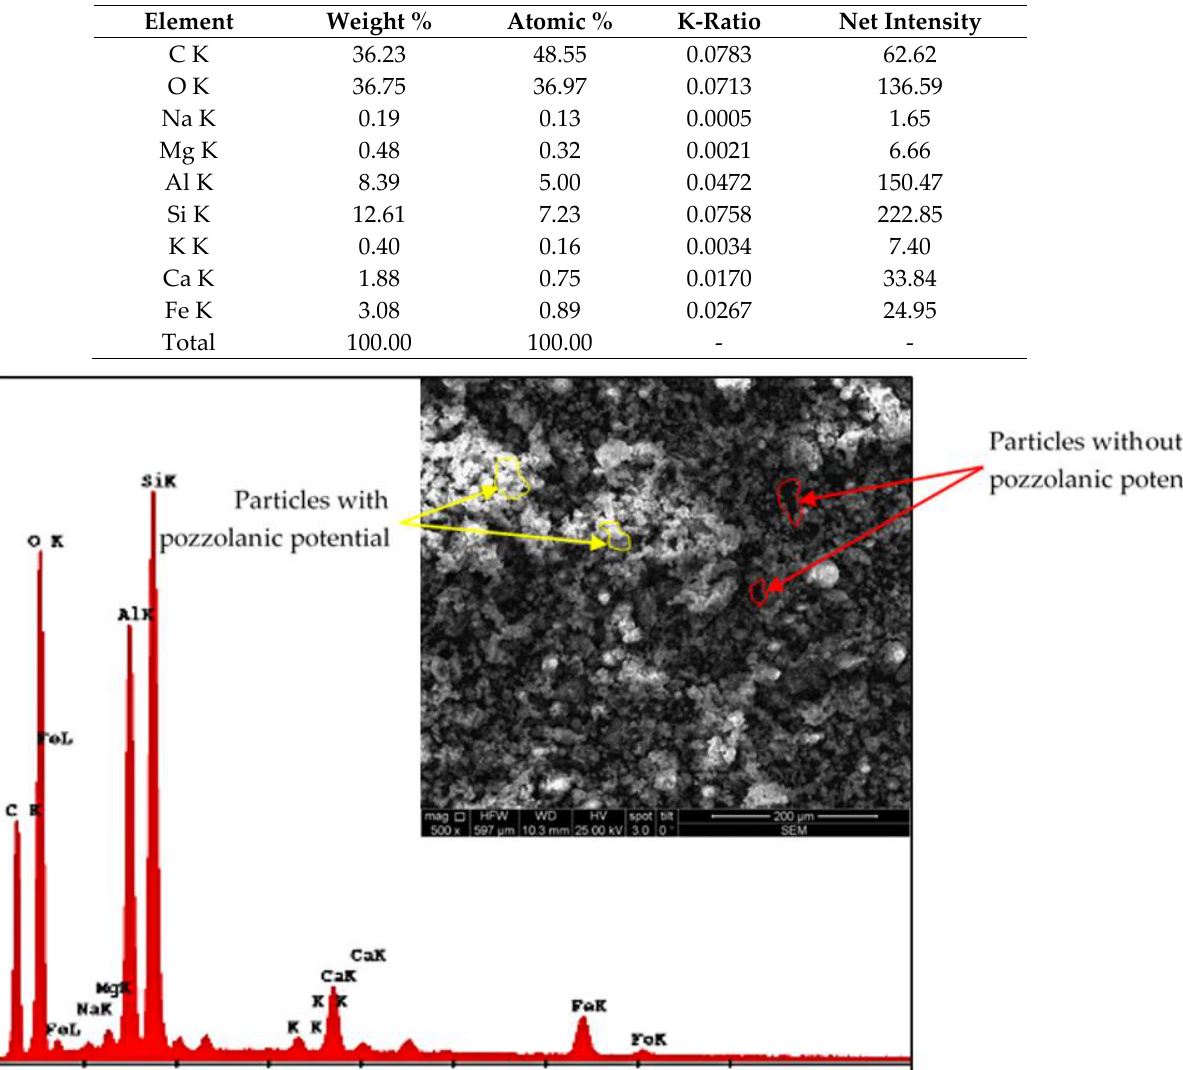
i and SEM image of particles at a ,